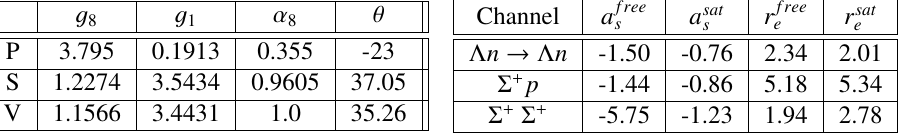
Table 1. Fitted parameter values of the revived SU(3) OBEP hyperon model (left), Calculated scattering lengths and e ff ective range in free space and at nuclear saturation density